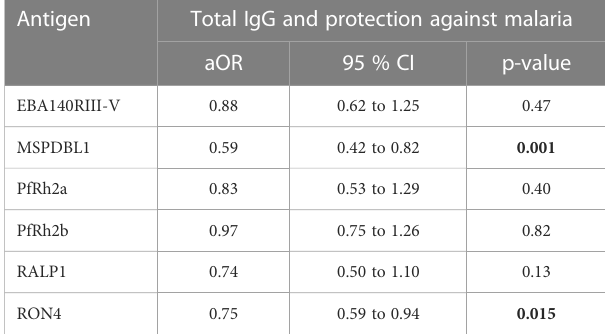
TABLE 2 Association between total IgG levels and protection against febrile malaria. Antigen